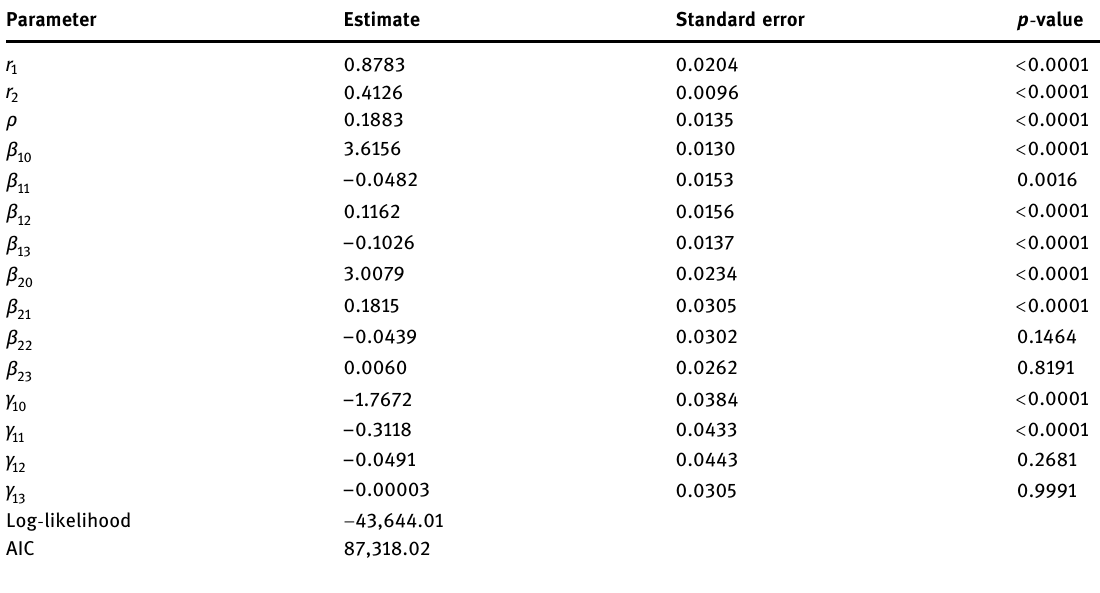
Table 5: Parameter estimates for =